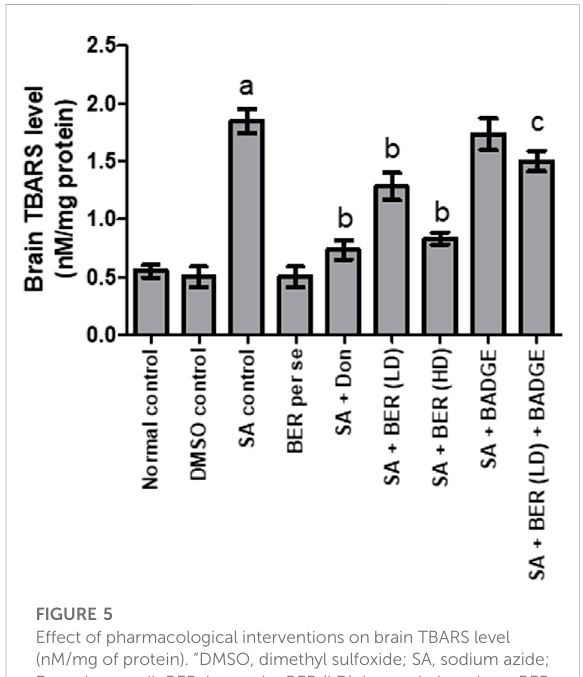
FIGURE 6 Effect of pharmacological interventions on brain MPO level (U/mg of protein). “ DMSO, dimethyl sulfoxide; SA, sodium azide; Don, donepezil; BER, bergenin; BER (LD), bergenin low dose; BER (HD), bergenin high dose; BADGE, Bisphenol A diglycidyl ether ” (Mehra et al., 2015). “ Each group ( n = 6) represents mean ± S.E.M, a = p ˂ 0.05 vs. normal control, b = p ˂ 0.05 vs. normal control, c = p ˂ 0.05 vs. SA control. One way ANOVA followed by Bonferroni ’ s multiple range test ” (Sodhi and Singh,